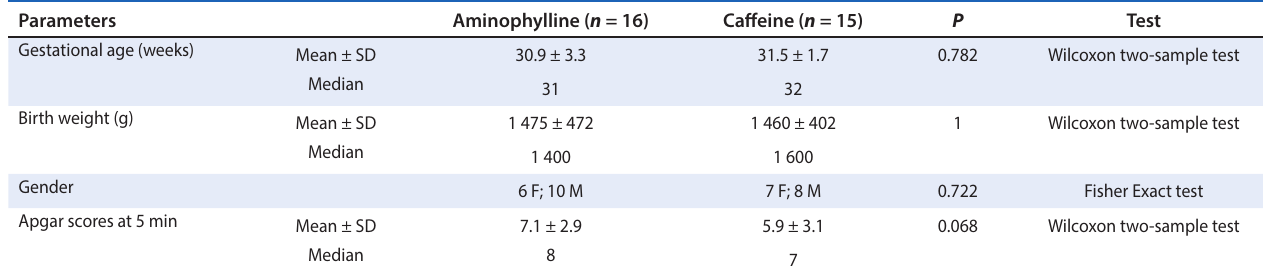
Table 1: Comparative demographics between two study groups